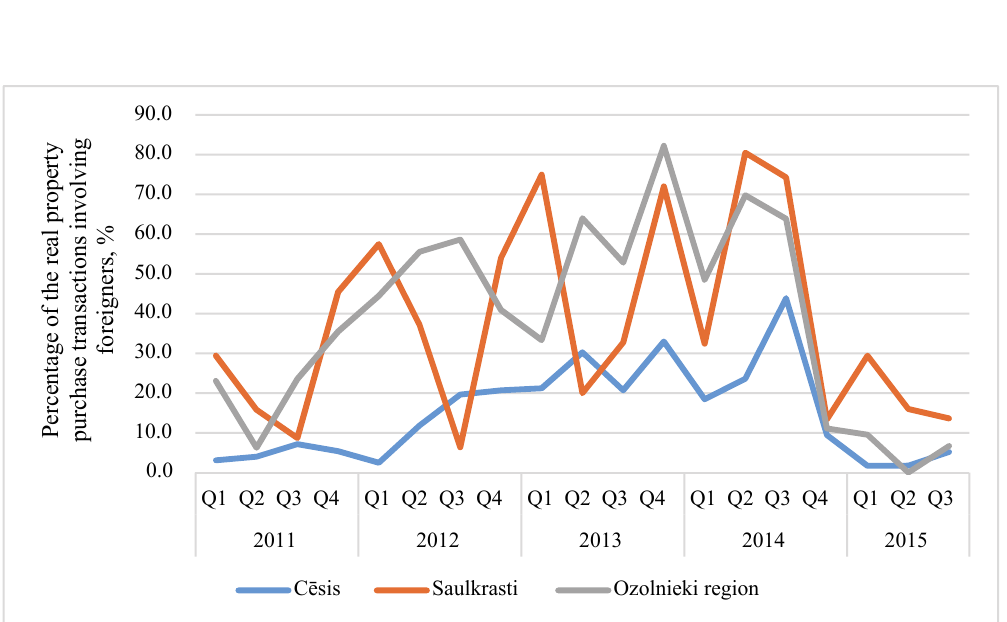
Fig. 4 . Dynamics of the percentage of the total number of real property purchase transactions in which foreigners were involved in the cities of Saulkrasti and Cēsis and in Ozolnieki region from 2011 Q1 to 2015 Q3 (developed by the authors based on the data of the State Land Service of Latvia).